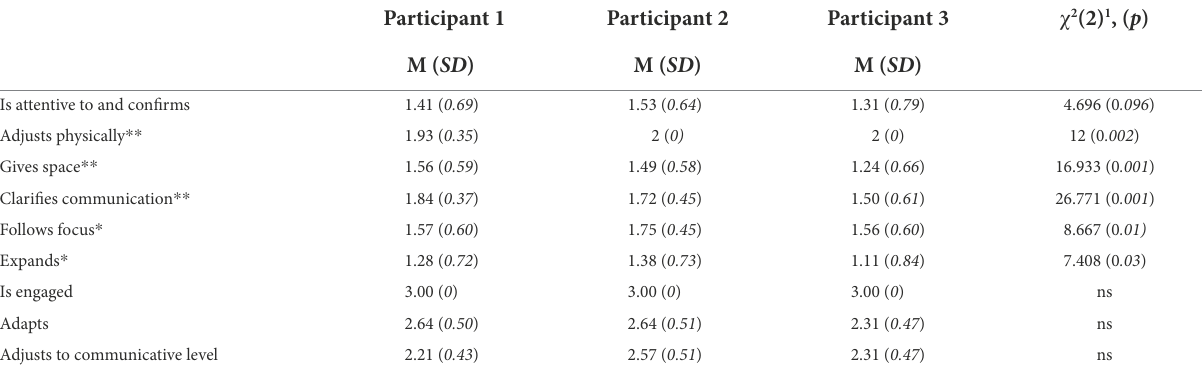
TABLE 3 RAACS score across